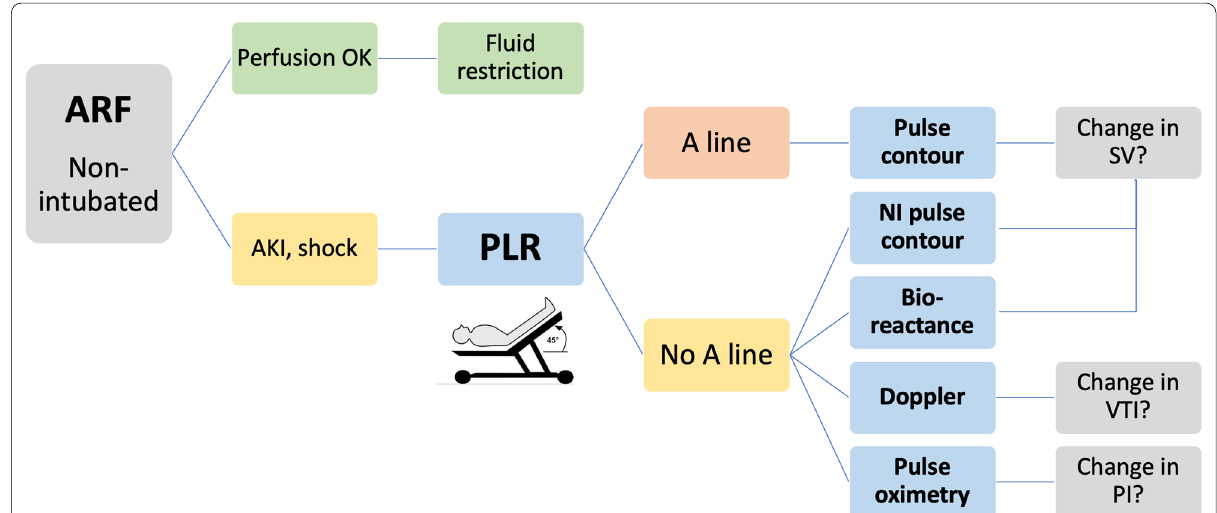
Fig. 1 How to predict fluid responsiveness in non-intubated patients with acute respiratory failure (ARF). PLR, passive leg raising maneuver; A line, arterial line; NI, non-invasive; SV, stroke volume; VTI, velocity time integral; PI, perfusion